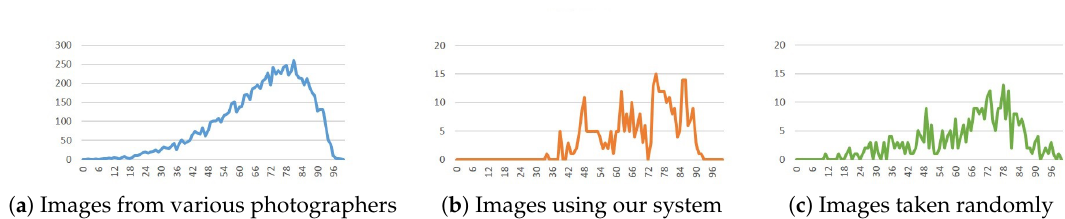
Figure 46. Results for the intensity balance composition method.